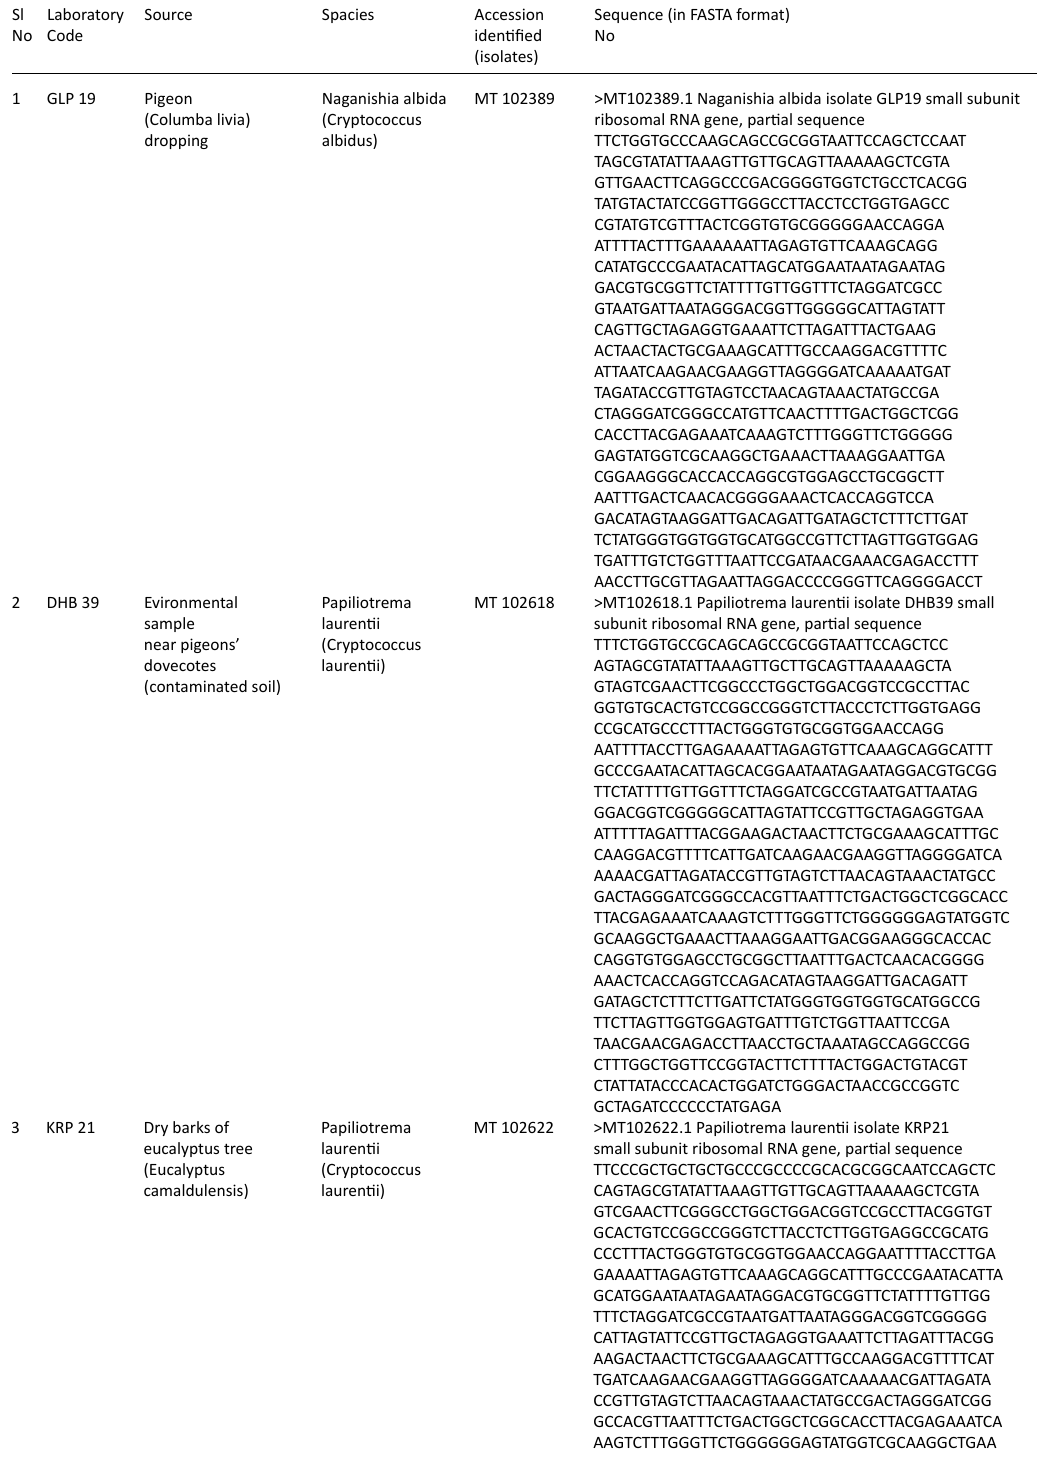
Table 7. Sequence data of Cryptococcus species isolated from different